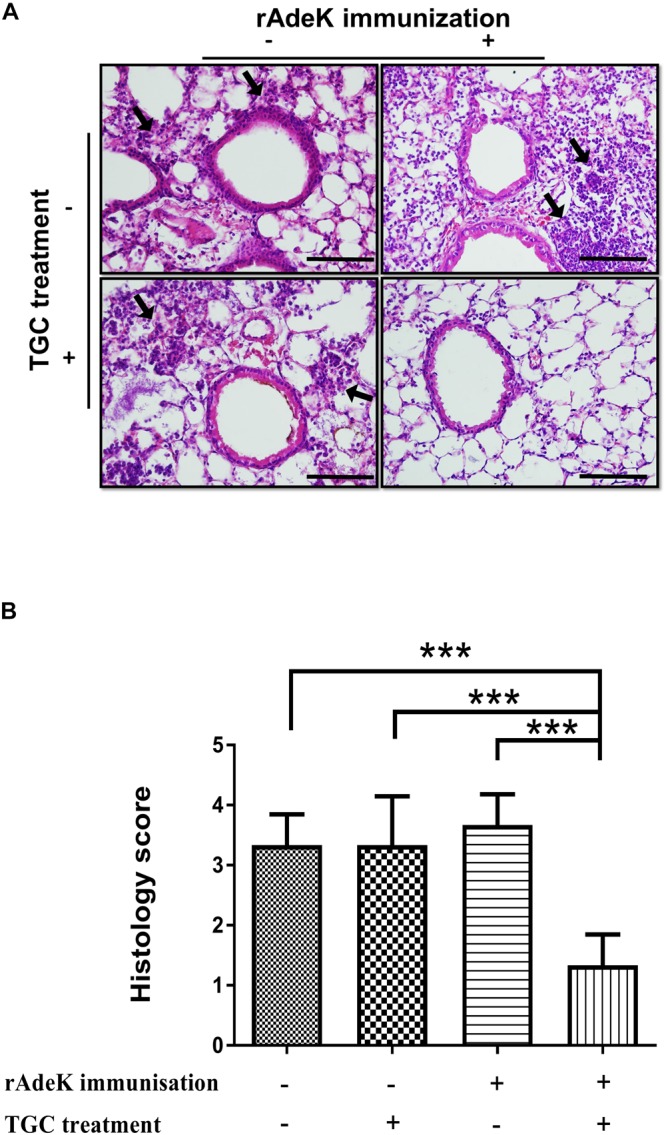
The histology of mouse lung sections in pneumonia model. (A) Hematoxylin and eosin staining of mouse lung sections obtained from each group. Images were taken at 40× by light microscopy and represented sections from three mice per group. The arrows indicate regions of peri-bronchovascular infiltration. Bars = 100 μm. (B) Lung inflammation was scored, the bars indicate the means of at least three samples ± SEM. ***p < 0.001.